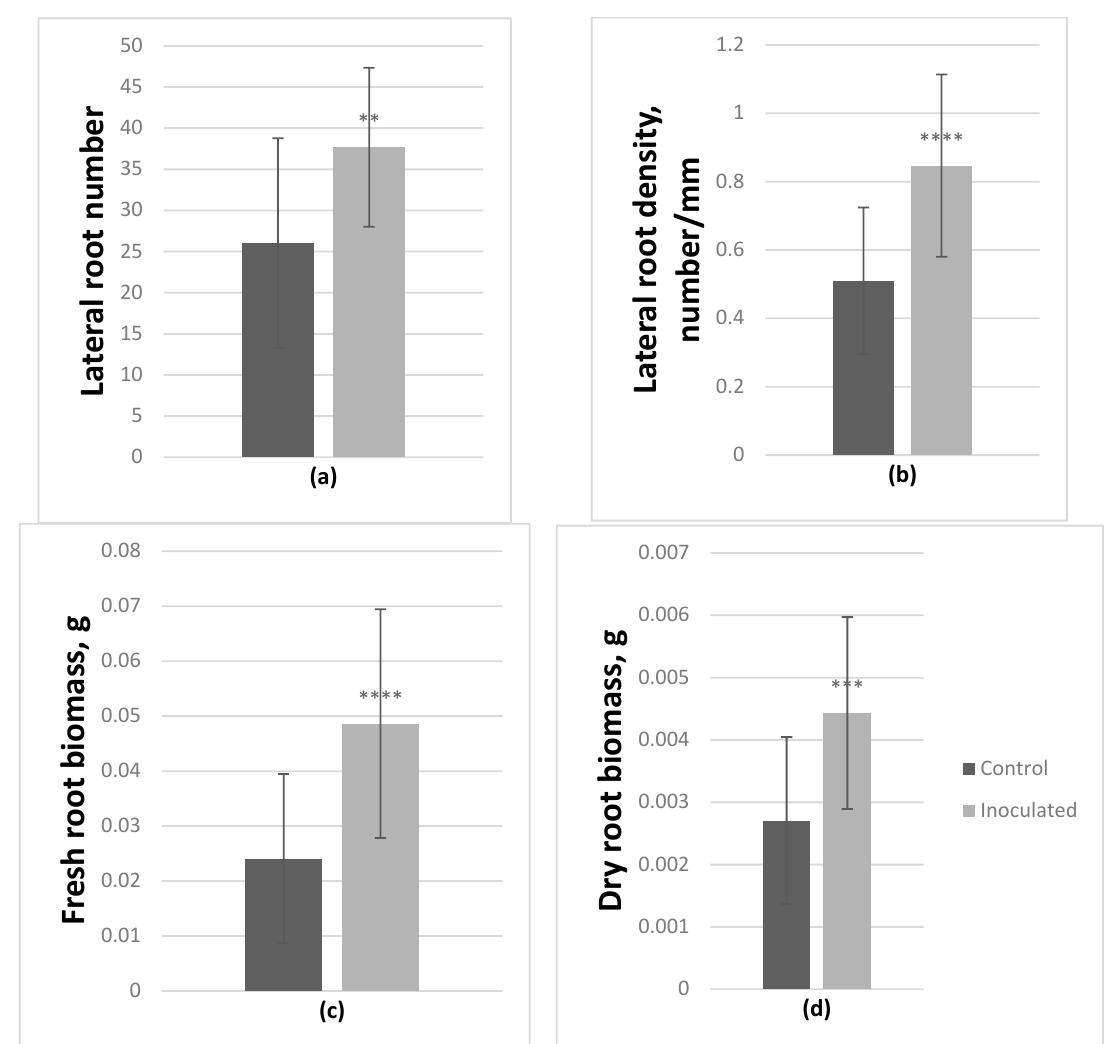
Figure 3. Effect of Paenibacillus sp. inoculation on P. tremula microshoots in vitro after 2-month incubation. On average lateral root number ( a ) and density ( b ) increased by 44.7% and 66% respectively, fresh root biomass ( c ) increased by 101.9% and dry root biomass ( d ) by 63.6% (average from 30 explants ± SD, **— p ≤ 0.01, ***— p ≤ 0.001, ****— p ≤ 0.0001).